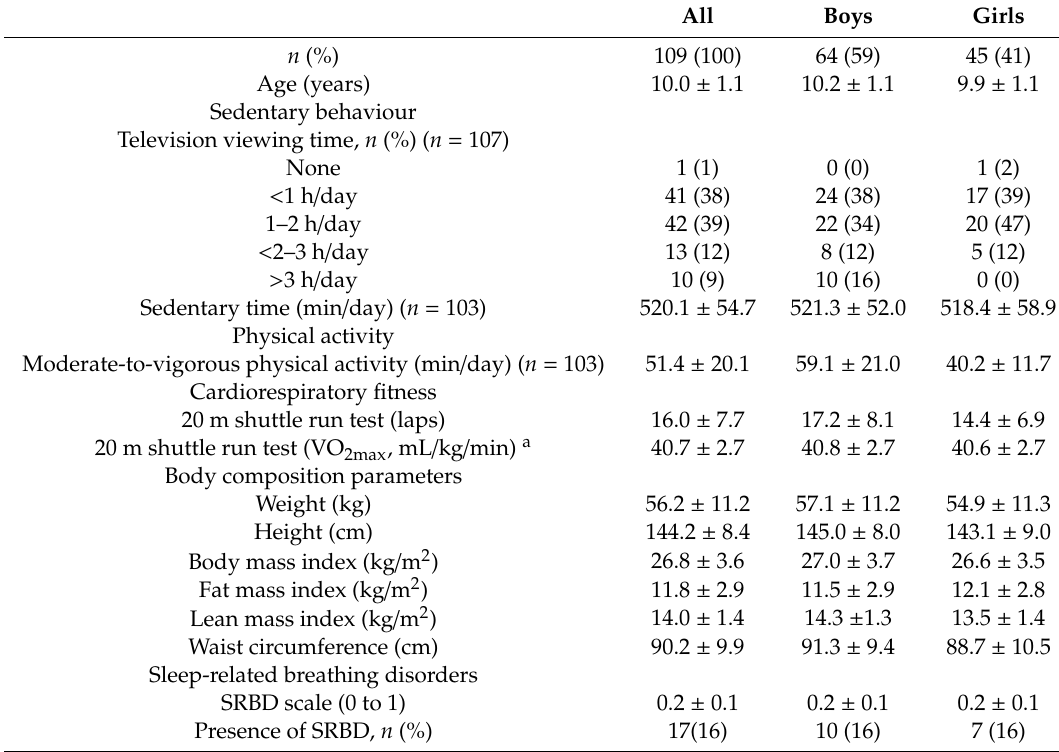
Table 1. Descriptive characteristics of the